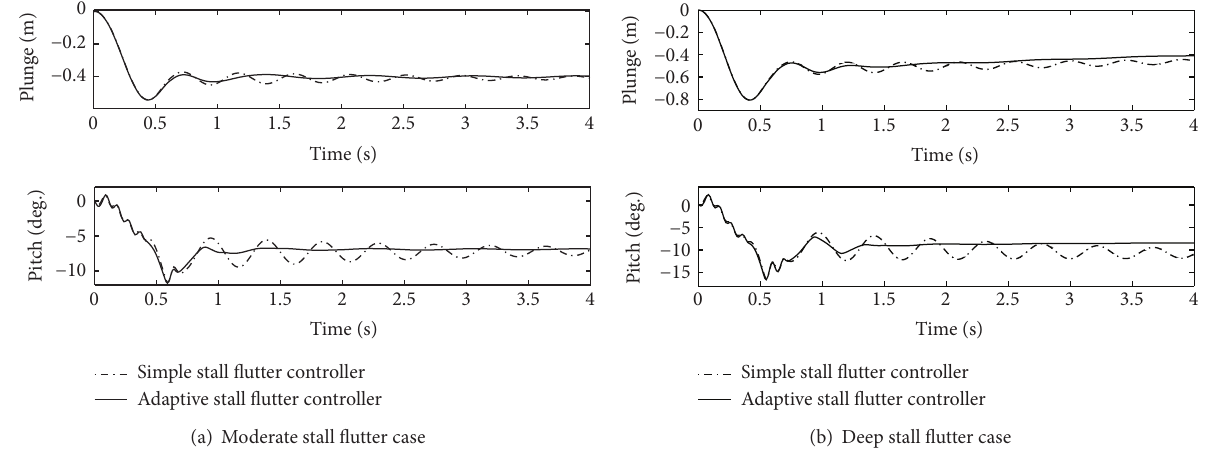
Figure 15: Response of the closed-loop system with simple stall flutter controller and adaptive stall flutter controller for (a) moderate stall flutter case and (b) deep stall flutter